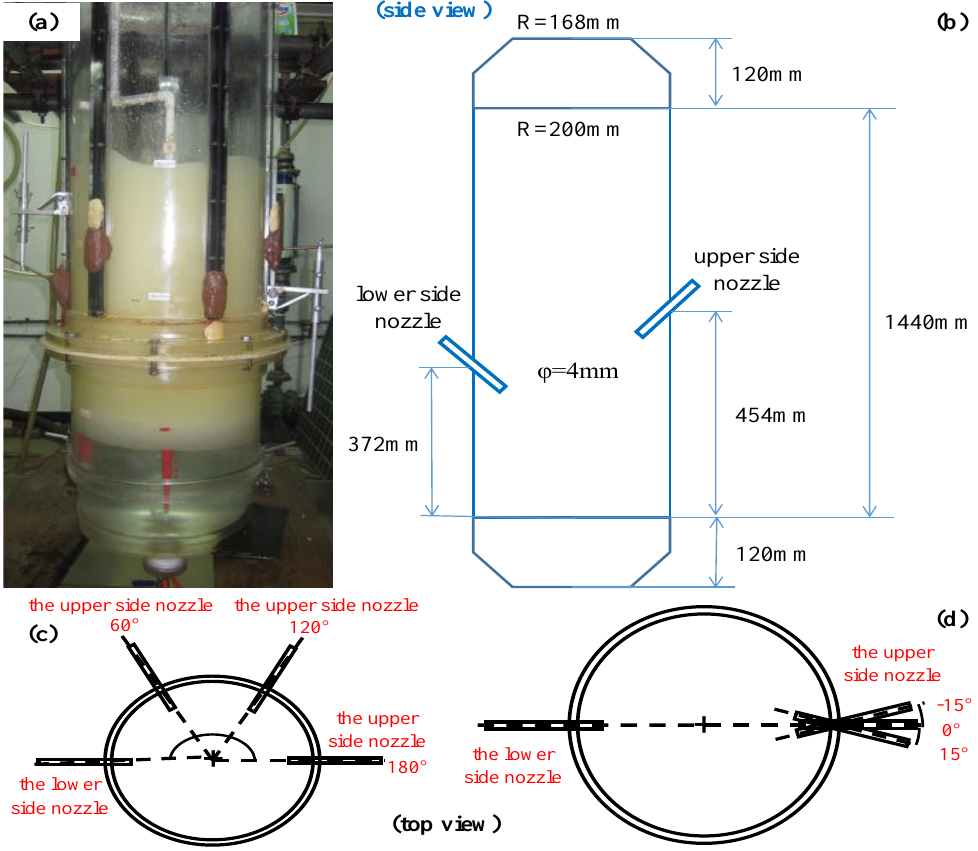
Figure 3. Prototype ( a ) and dimensions ( b ) of water model, the relative angle between the upper side nozzle and the lower side nozzle ( c ), the horizontal angle of the upper side nozzle and the lower side nozzle ( d ).